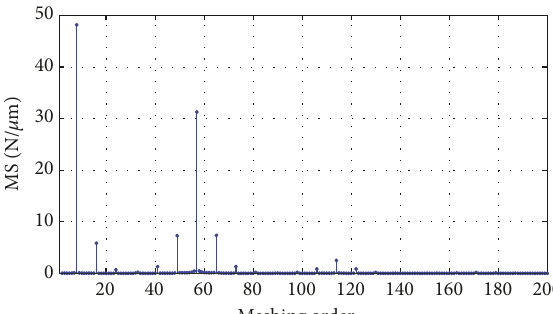
Figure 15: FFT analysis of the mesh stiffness obtained from STE curves of Figure 14.